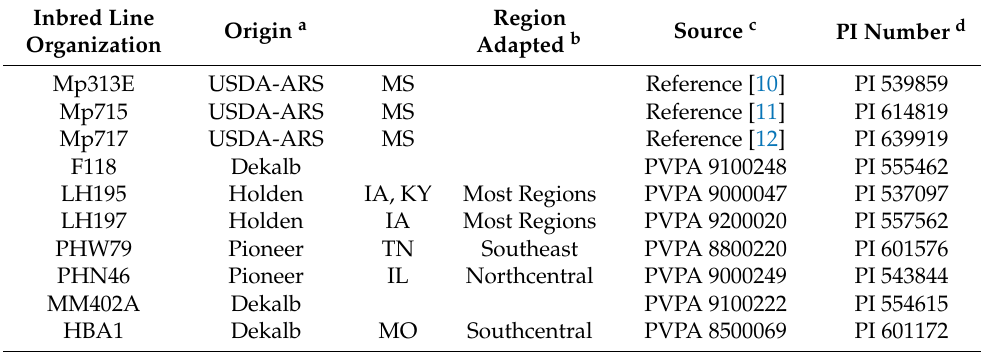
Table 1. Inbred lines included in diallel.